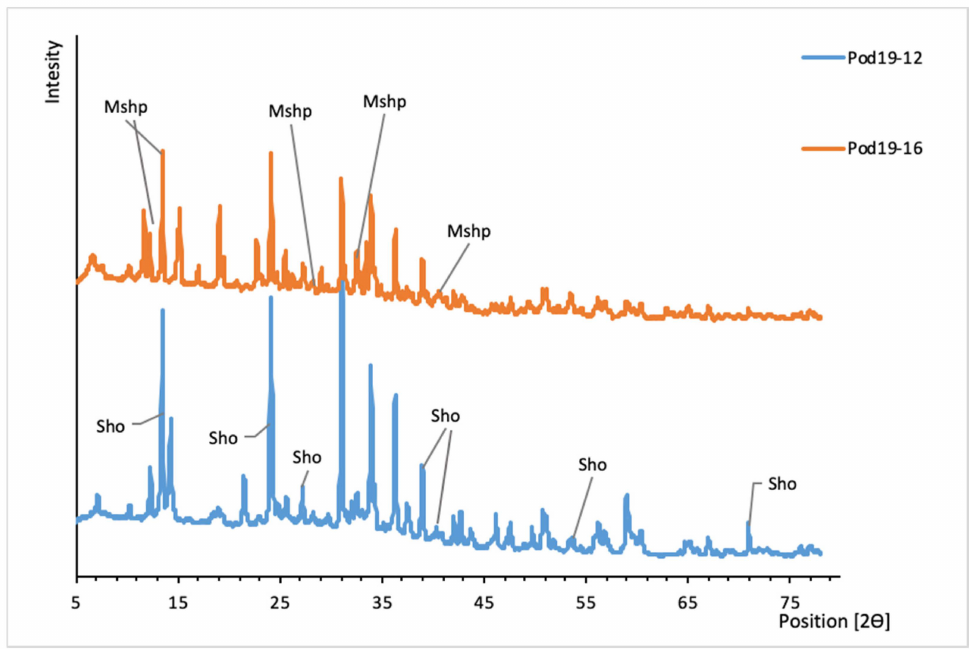
Figure 13. XRD patterns of uranyl oxide-hydroxides from Podg ó rze mine. Sho, schoepite; Mshp,